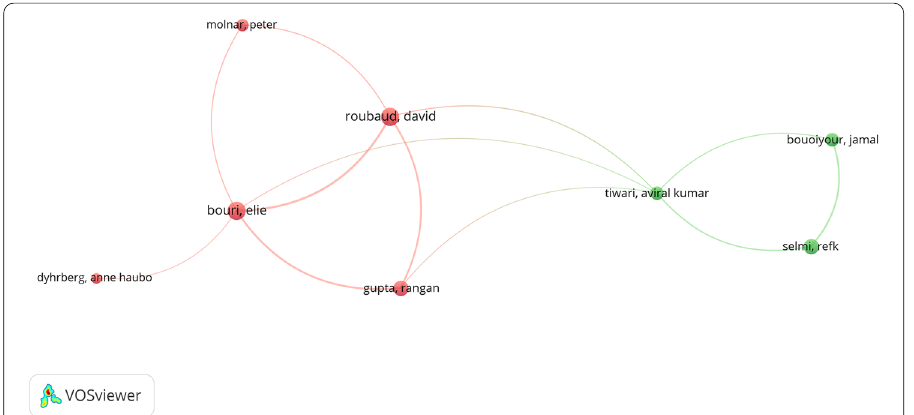
Fig. 7 Author cluster on WoS. Source : Own